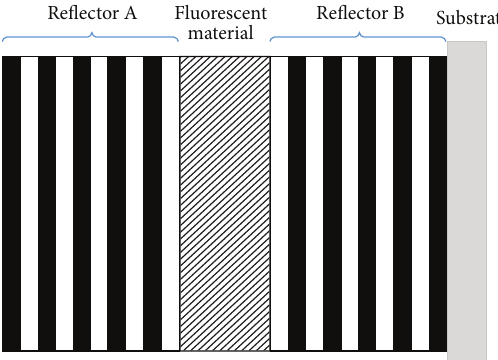
Figure 3: Structure design of one-dimensional photonic